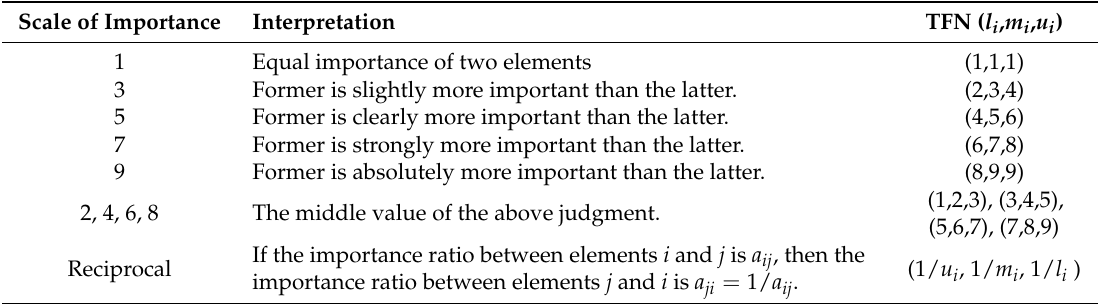
Table 1. The relational scale for pairwise comparisons with